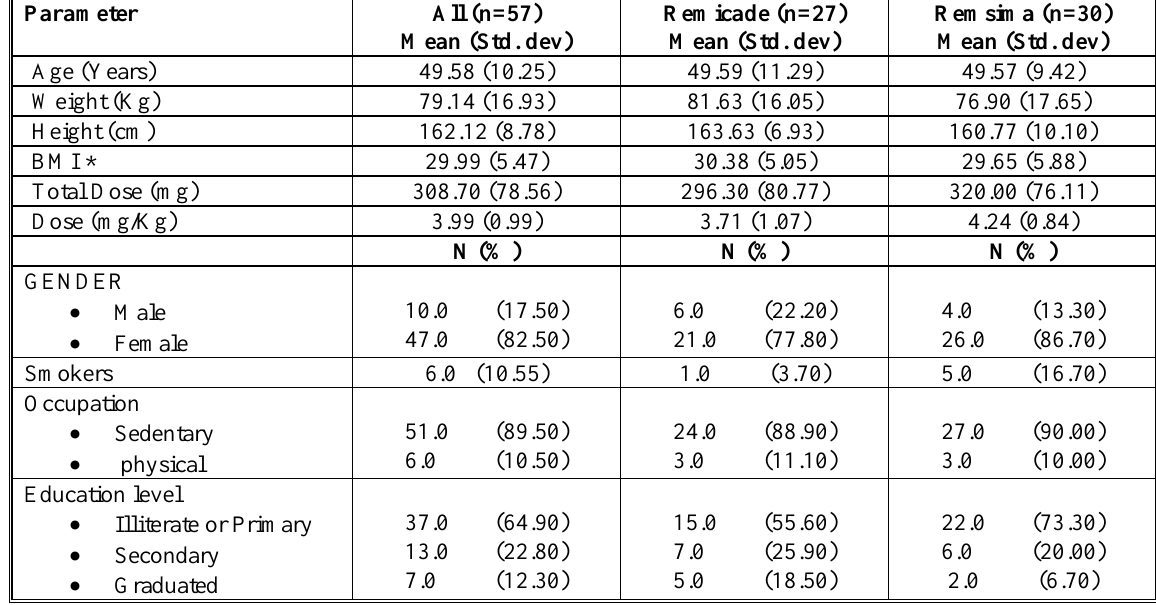
Table 1. The characteristics of the participating rheumatoid arthritis patients